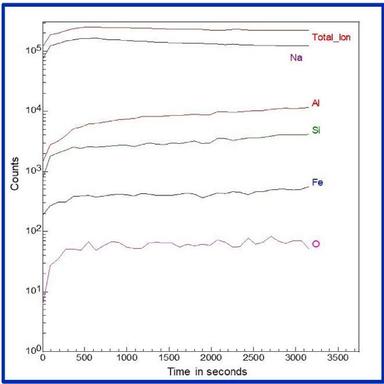
SIMS profile for acquisition time 87min showing abundance of compositional elements at the coating-Fe interface with respect to sputtering time with 30 kV Ga+ gun, raster size 100um and 3 kV Cs+ sputter gun, raster size 750um.